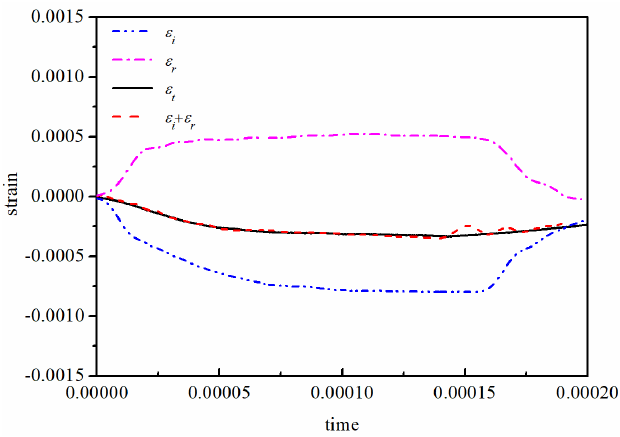
Figure 2. Stress equilibrium condition in specimen.